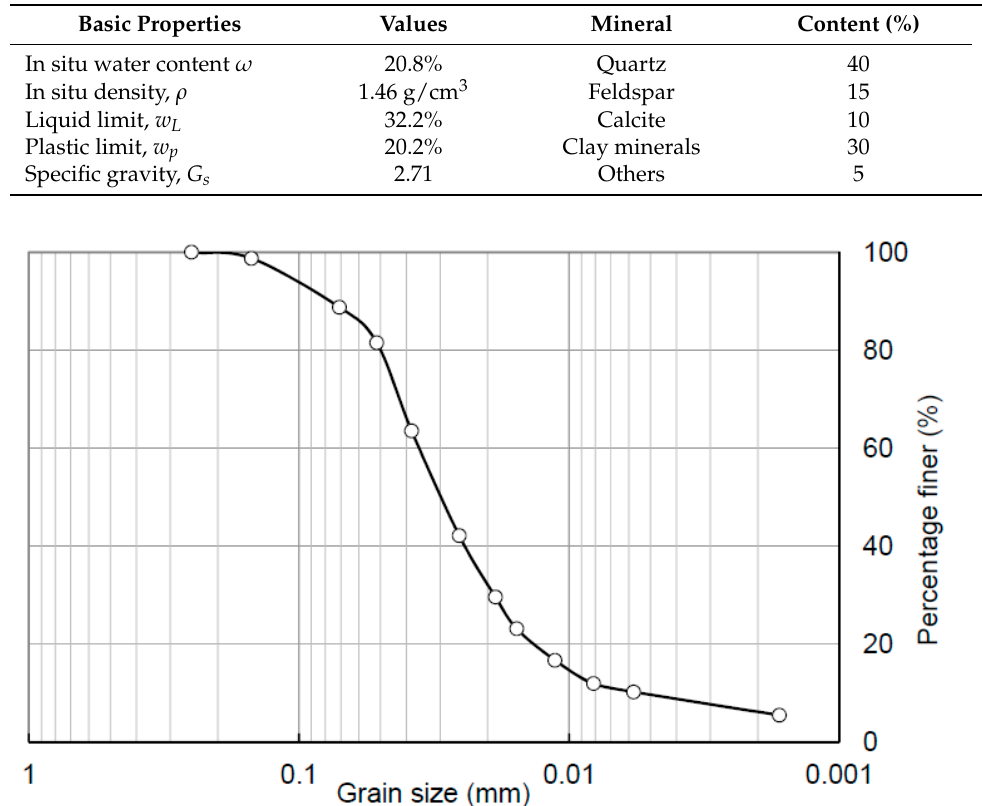
Figure 2. Particle size distribution curve of intact loess sample.